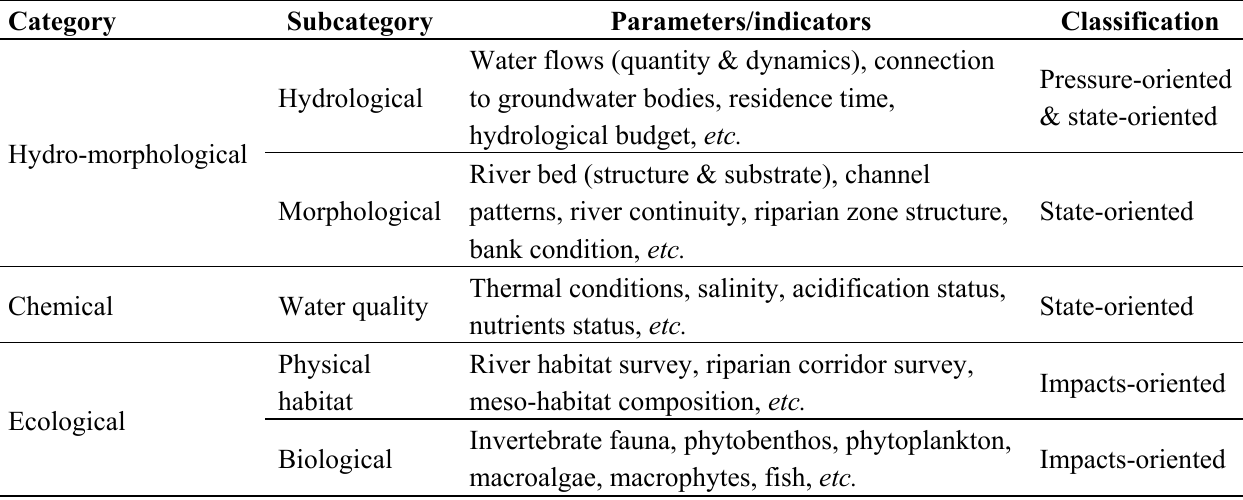
Table 1. DPSIR-based classification of monitoring techniques for river restoration